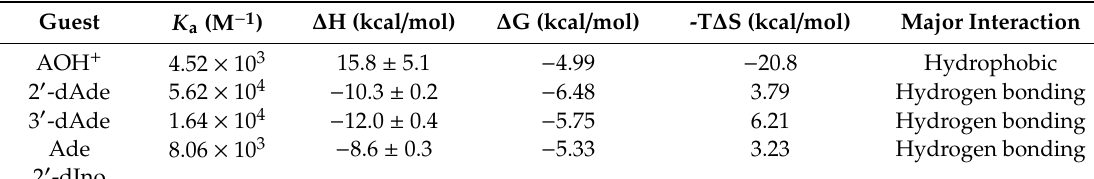
Table 1. Thermodynamic parameters of complex formation between CB7 and guests (AOH + and di ff erent nucleosides) assessed by isothermal titration calorimeter in 10 mM ammonium acetate bu ff er (pH 4.0).